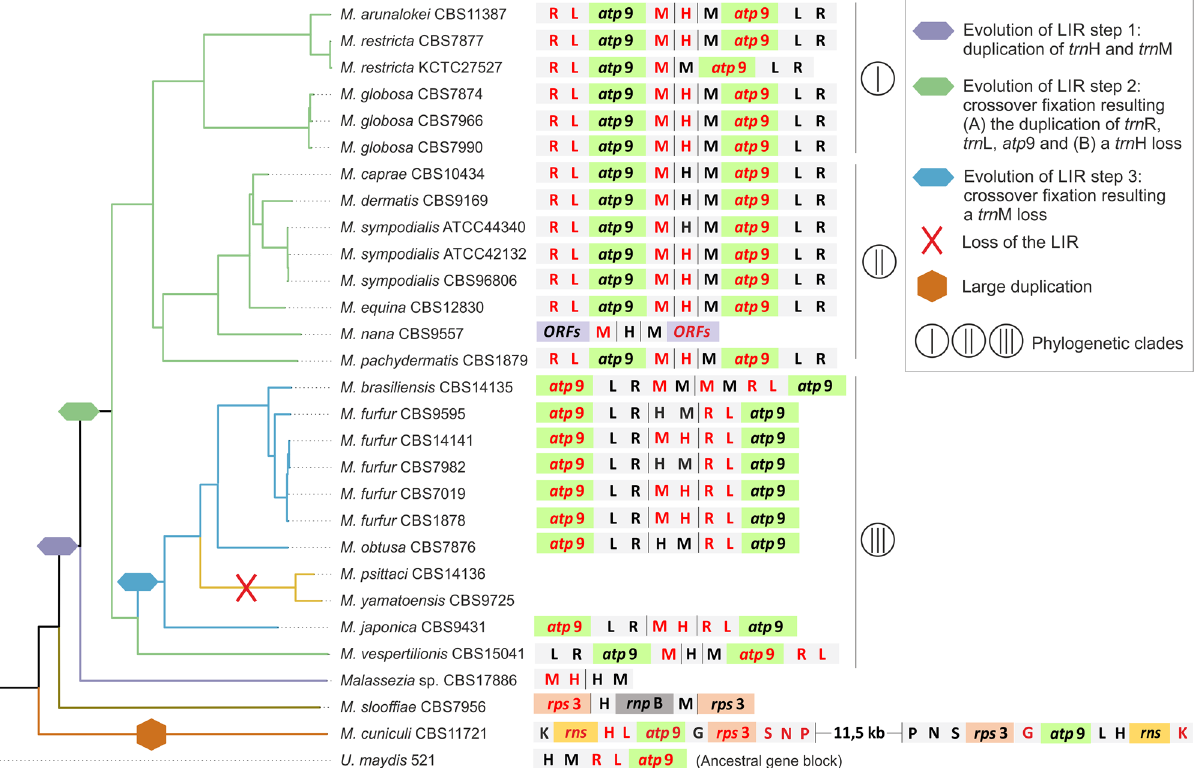
Figure 3. Schematic representation of Malassezia LIR evolution in relation to phylogeny. LIRs synteny is presented next to the respective phylogenetic clade. The intra-IR region can be seen in between black vertical lines. The genes located on the complementary reverse strand are indicated in red coloring and amino acid symbols represent the corresponding tRNA gene (e.g., H for trn H). The main evolutionary steps are shown as different colored symbols of the nodes and clades of the tree. Latin numbers in circles indicate the three different phylogenetic clades. The ancestral gene block of Ustilago maydis is